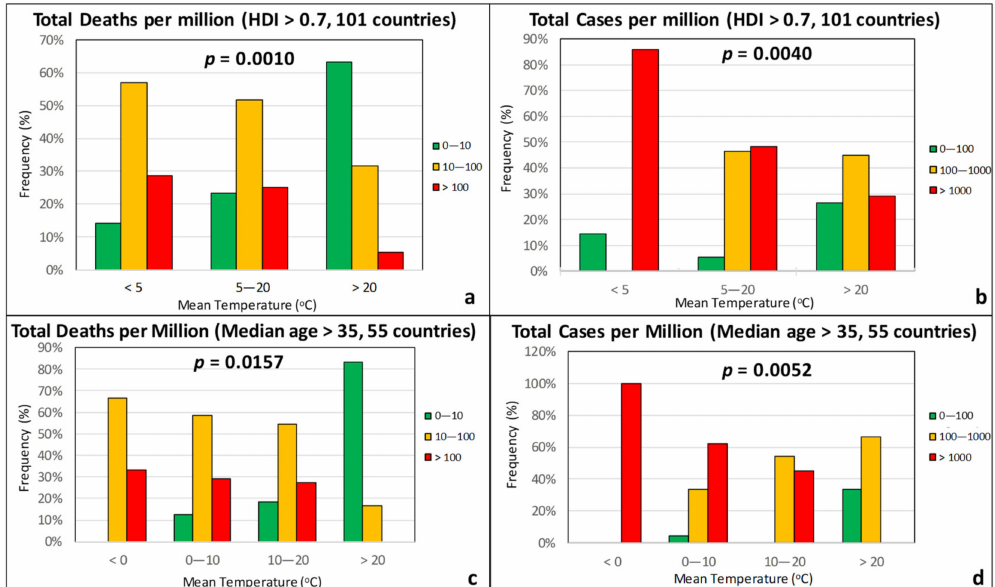
Figure 4. Frequency of total deaths per million (green: low, 0–10; orange: moderate, 10–100; red: high, > 100) and total cases per million (green: low, 0–100; orange: moderate, 100–1000; red: high, > 1000) as a function of the average temperature for countries with an HDI over 0.7 ( a , b ) and a median age over 35 years ( c , d ).